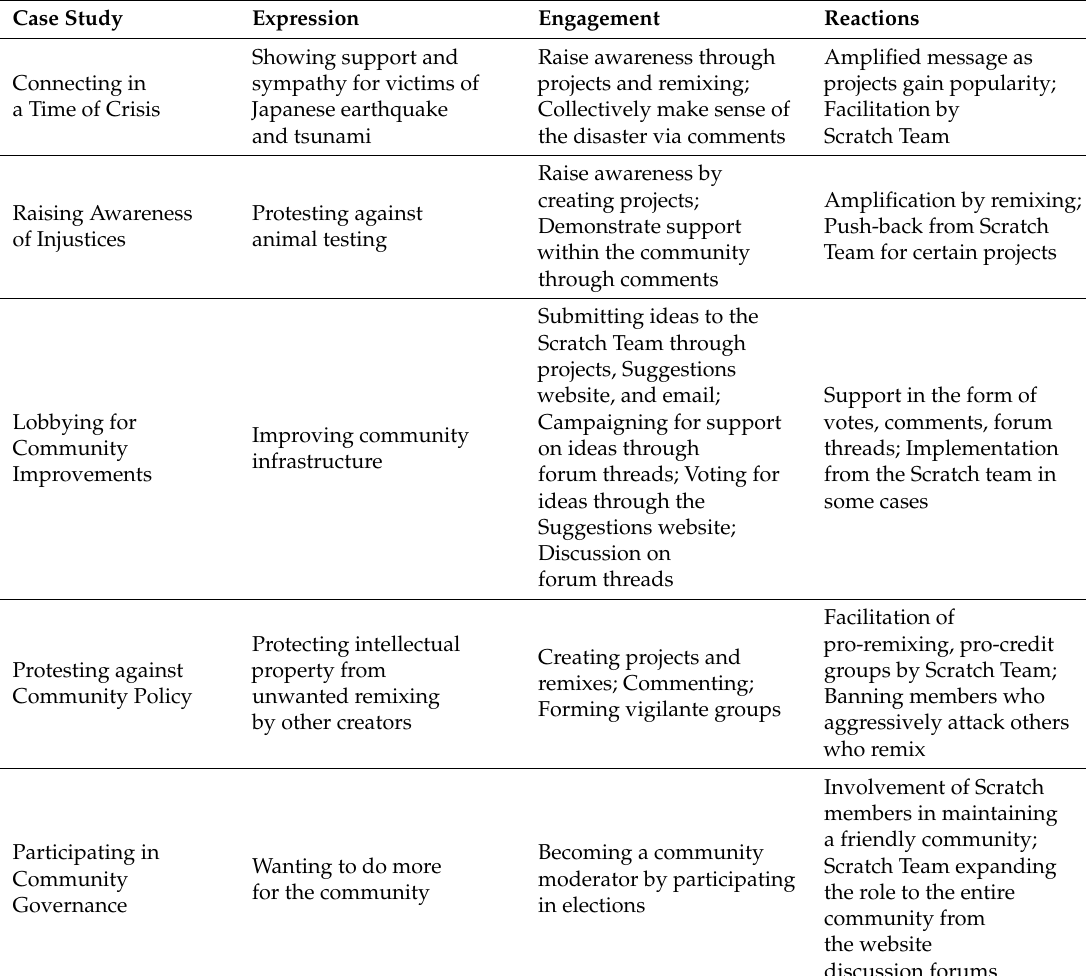
Table 1. A summary of our five case studies across the expressions, engagement, and reactions from the Scratch